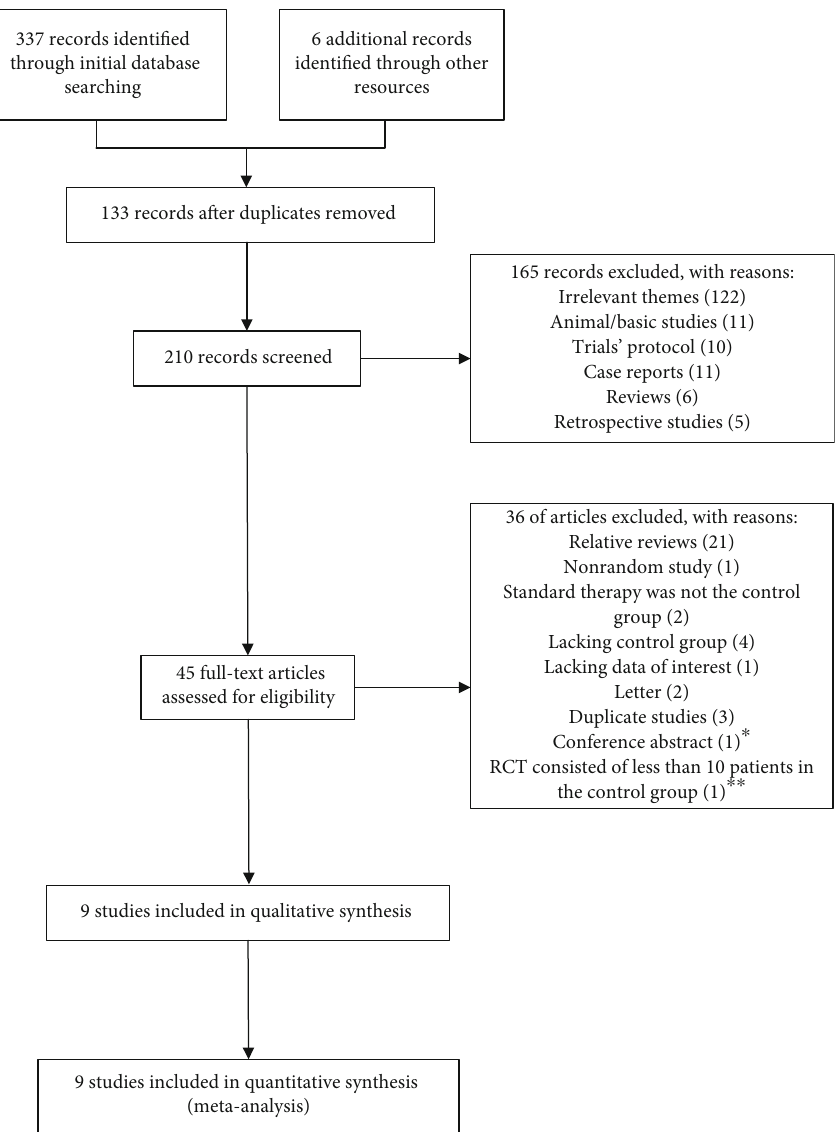
Figure 1: Flow chart of the study selection. ∗ The article was a conference abstract without available full text and lacked enough information to conduct a quality assessment. ∗∗ The RCT only included 6 patients in the control